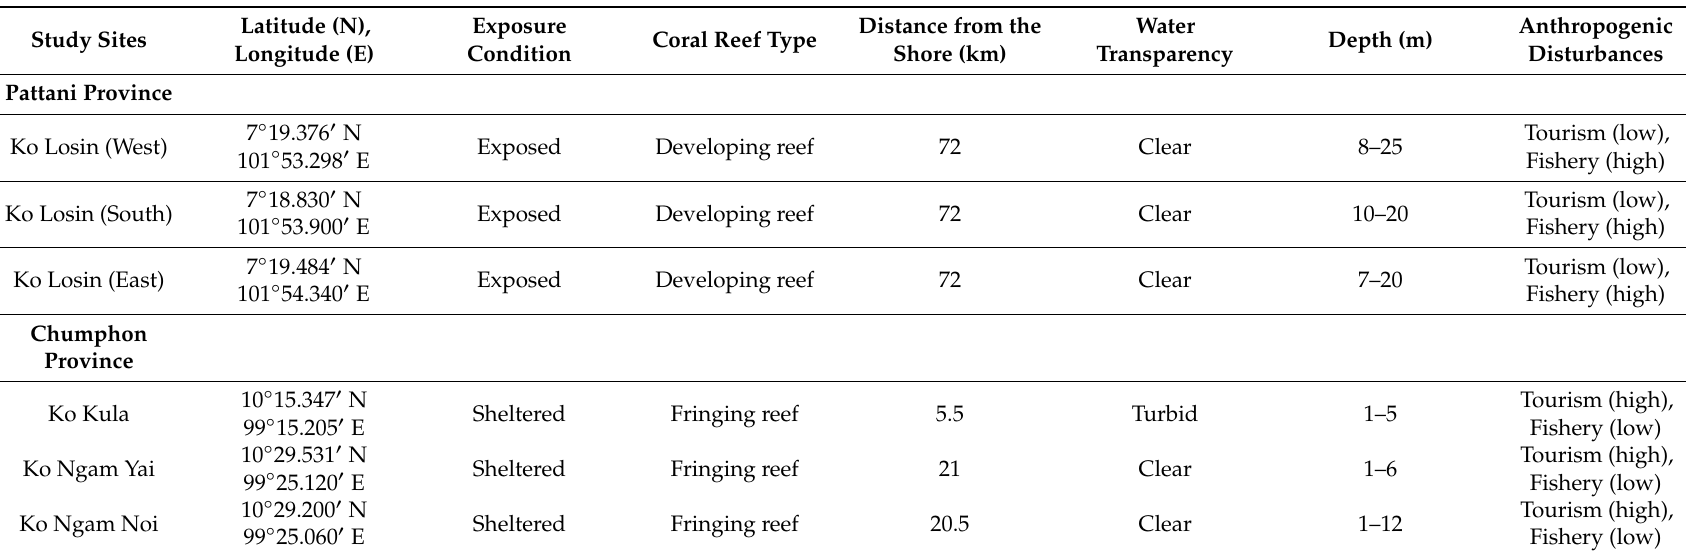
Table 1. Location and information of the study sites in the south of